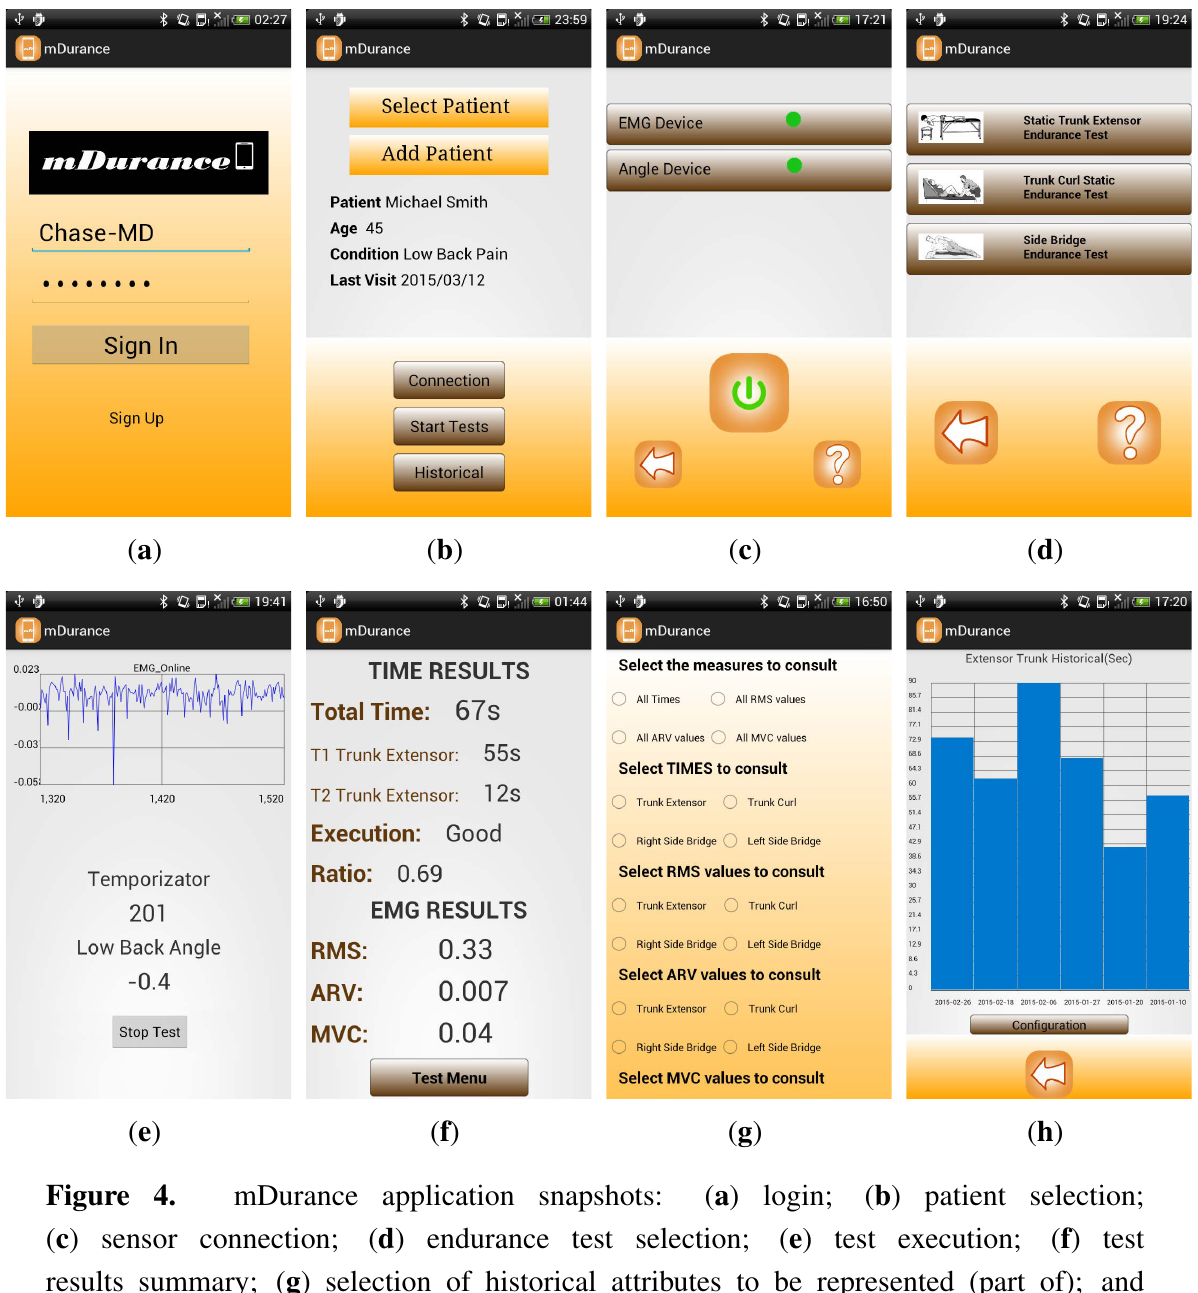
Figure 4. mDurance application snapshots: ( a ) login; ( b ) patient